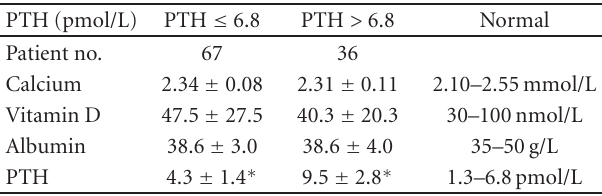
Table 2: Biochemical data categorized according to normal or increased PTH levels at 12 months after gastric bypass